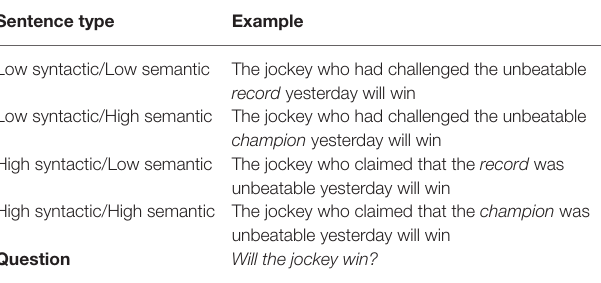
TABLE 2 | Examples of stimuli with syntactic and semantic interference (adapted from Tan and Martin, 2018).